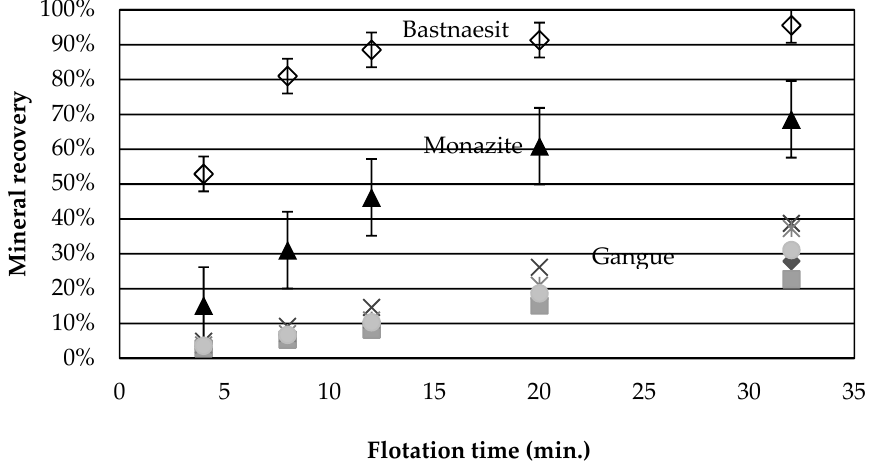
Figure 2. Mineral recovery as a function of time for tests 1, 7, and 10 (central point).